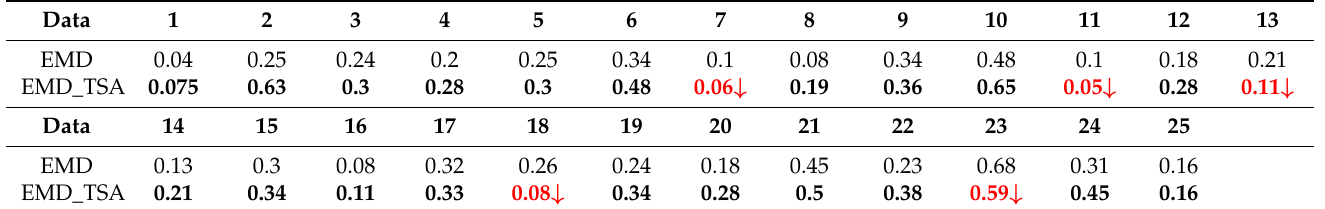
Bold font indicates the detection rate of EMD_TSA is higher than that of EMD model. Red font indicates that the detection rate of the EMD_TSA is lower than that of EMD model. Red arrows indicate the decrease of detection